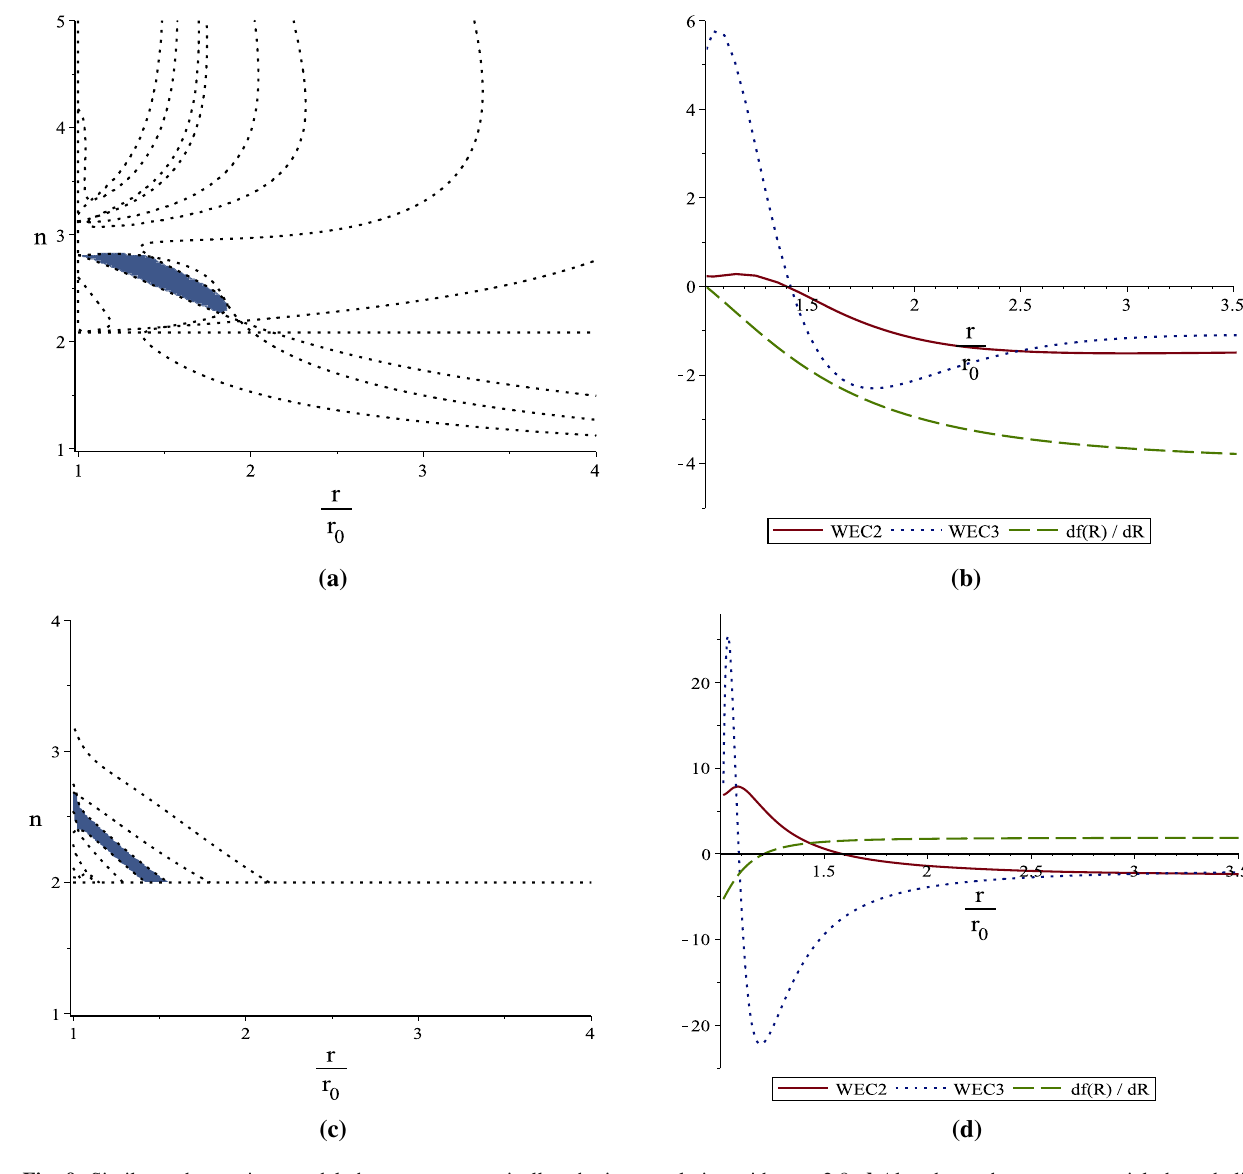
solution with n = 2 . 8. d Also shows that an asymptoticly hyperbolic wormhole with n = 2 . 5, respect the NEC. In these figures we set the parameters as μ = 10 , R ∗ = 1 , r 0 = .